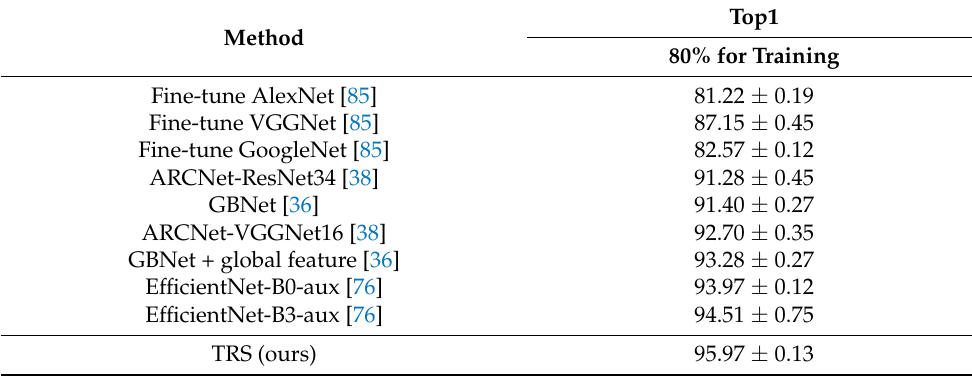
Table 6. Classification accuracy on OPTIMAL-31